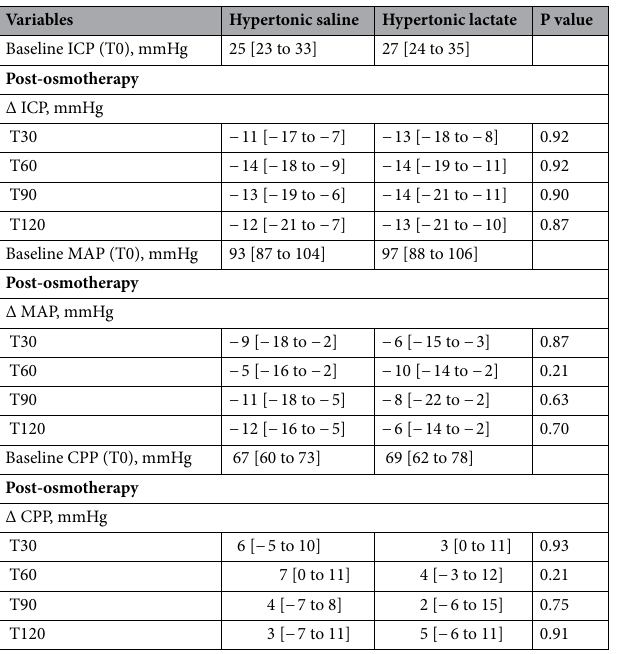
Table 2. Effectiveness of osmotherapy with hypertonic saline vs. hypertonic lactate on brain physiologic variables. Data are presented as median and interquartile range [25th–75th percentiles]. P values for comparisons of osmotherapy with hypertonic saline vs. hypertonic lactate (ANOVA for repeated measures adjusted for patient, time, treatment and time-treatment interaction). CPP cerebral perfusion pressure, ICP intracranial pressure, MAP mean arterial pressure.